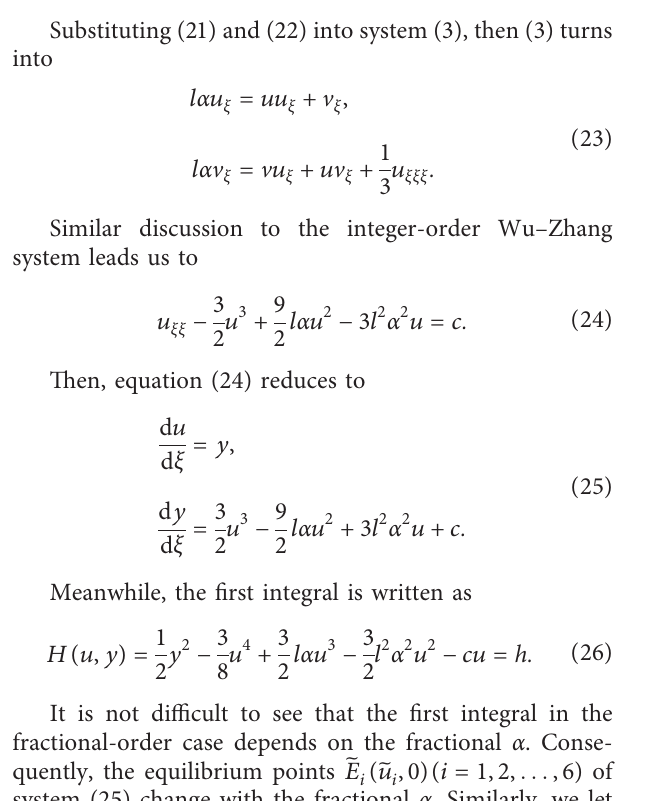
Figure 3: Solitary wave of (9) and exact solitary wave solutions of (2) when c � 0 . 2 and l �